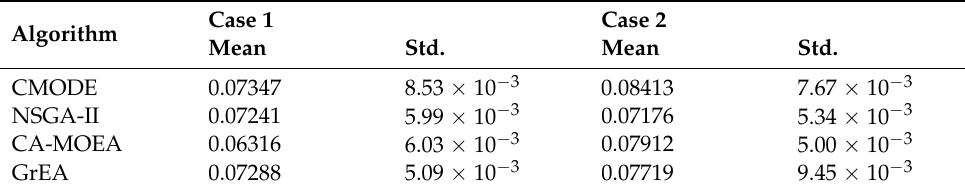
Table 4. Comparison of HV results.